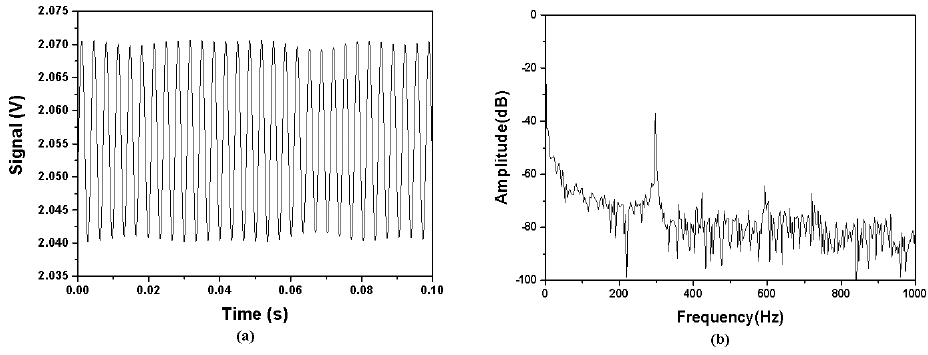
Figure 6: The demodulated vibration signals (a) and its FFT spectra (b) under the applied vibration frequency of 300 Hz and the acceleration of 2.5 g.